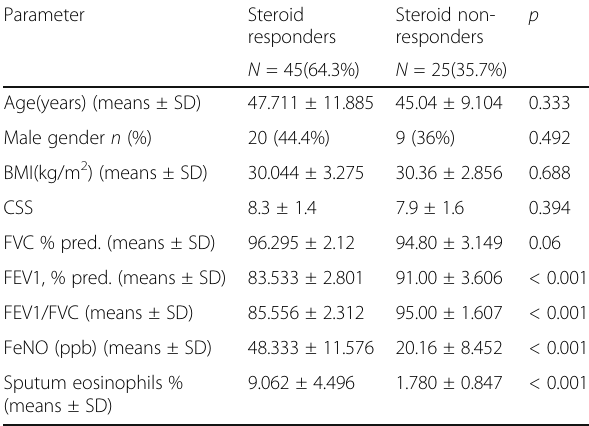
Table 2 Baseline characteristics of the studied patients according to steroid therapy responsiveness Parameter Steroid responders